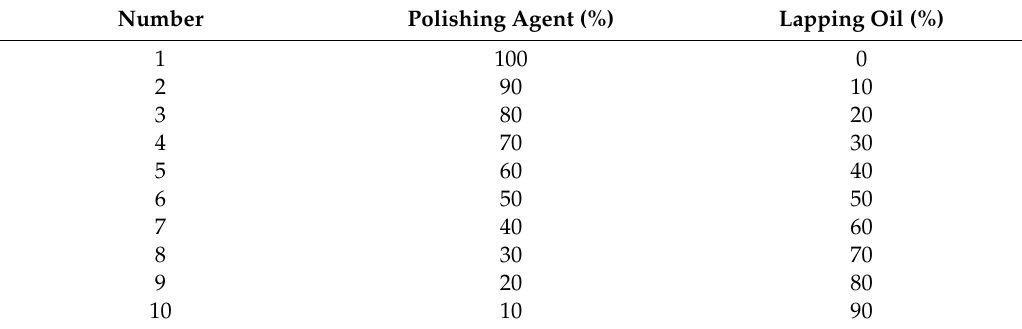
Table 2. Formulas of di ff erent polishing agents.